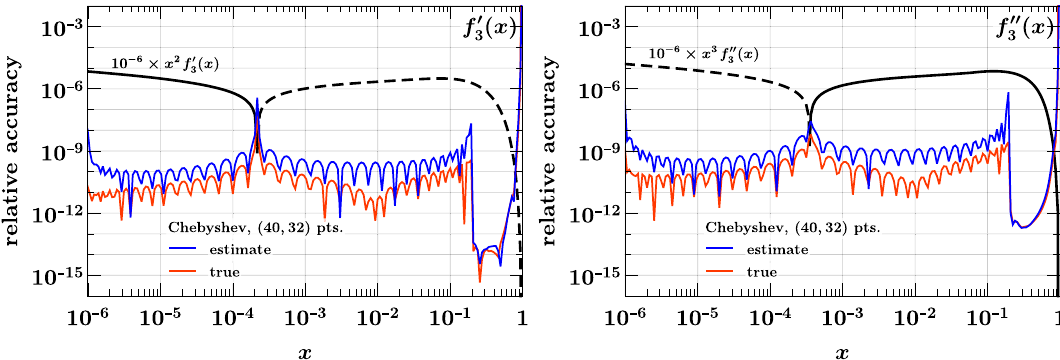
Fig. 8 Comparison of true (red) and estimated (blue) interpolation accuracy as in Fig. 7, but for the first and second derivative of the sample PDF f